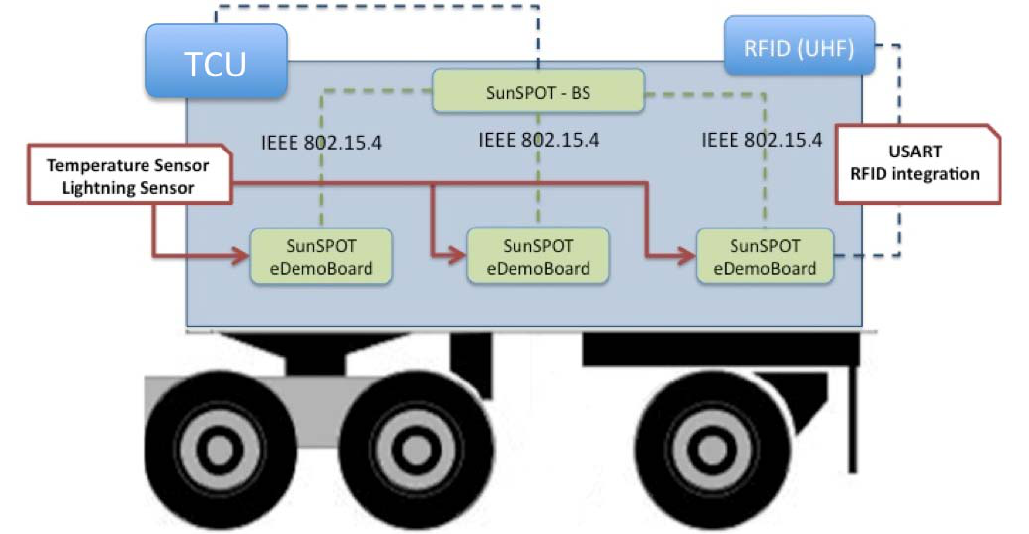
Figure 1. Tracking and Monitoring Architecture of the System installed inside the